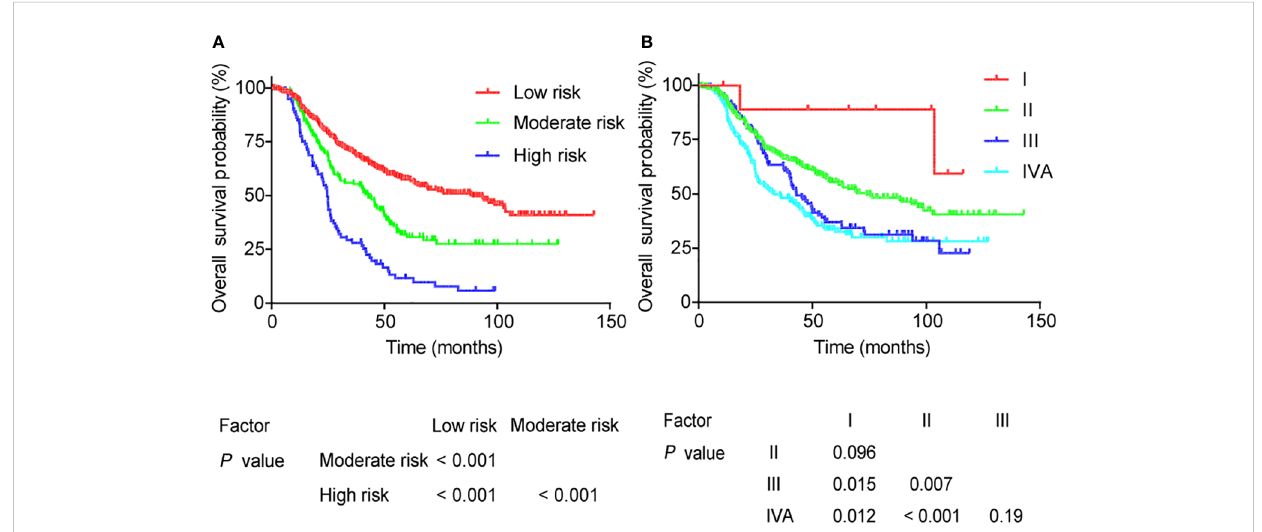
FIGURE 4 Overall survival for different groups as de fi ned by (A) the nomogram model and (B) the AJCC stage.